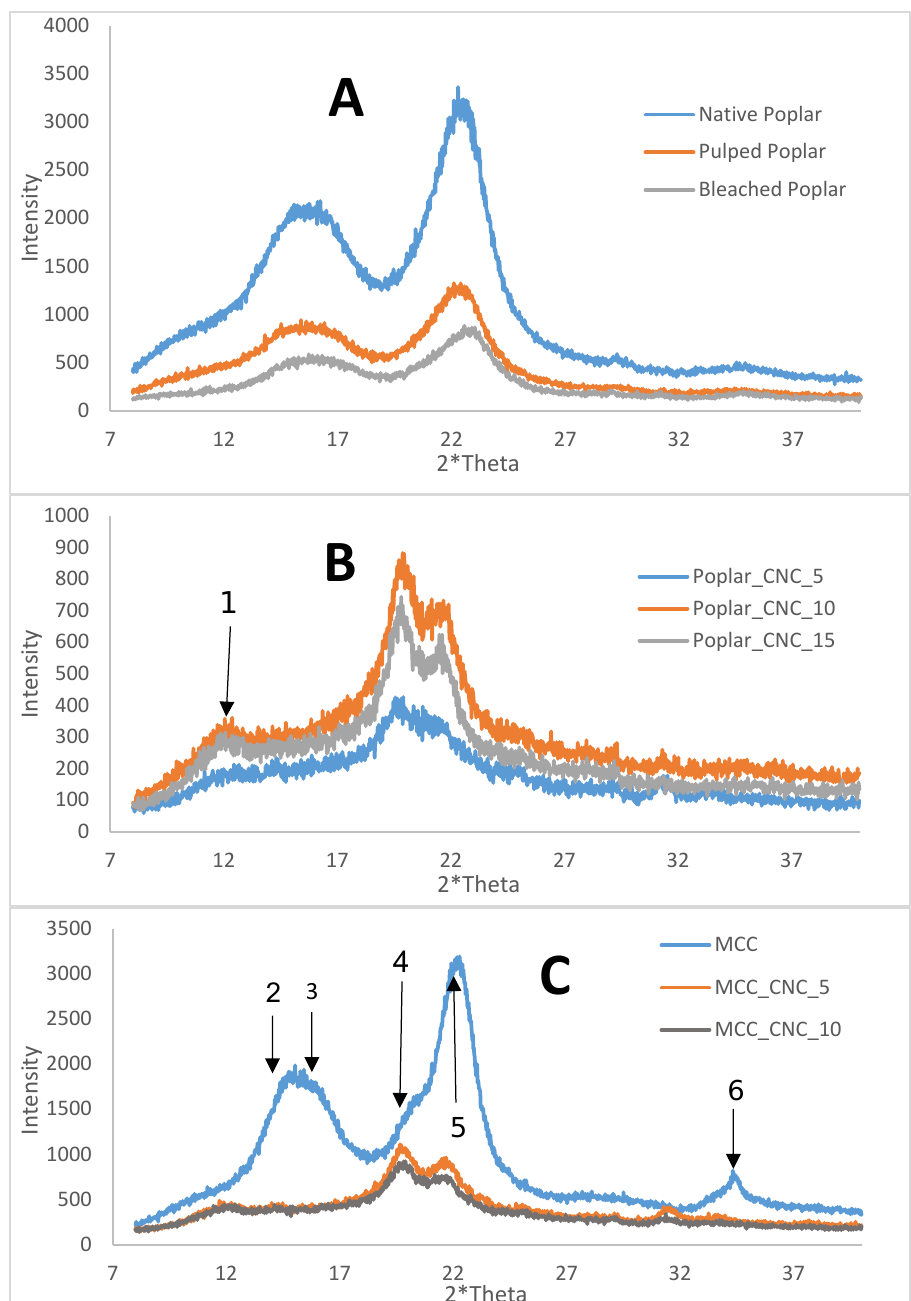
Figure 4. XRD characterization of ( A ) Native, pulped, and bleached poplar, ( B ) Cellulose nanocrystals (CNC) sourced from poplar after 4, 10, and 15 min of hydrolysis, and ( C ) microcrystalline cellulose (MCC) and CNC sourced from MCC after 5 and 10 min of hydrolysis.